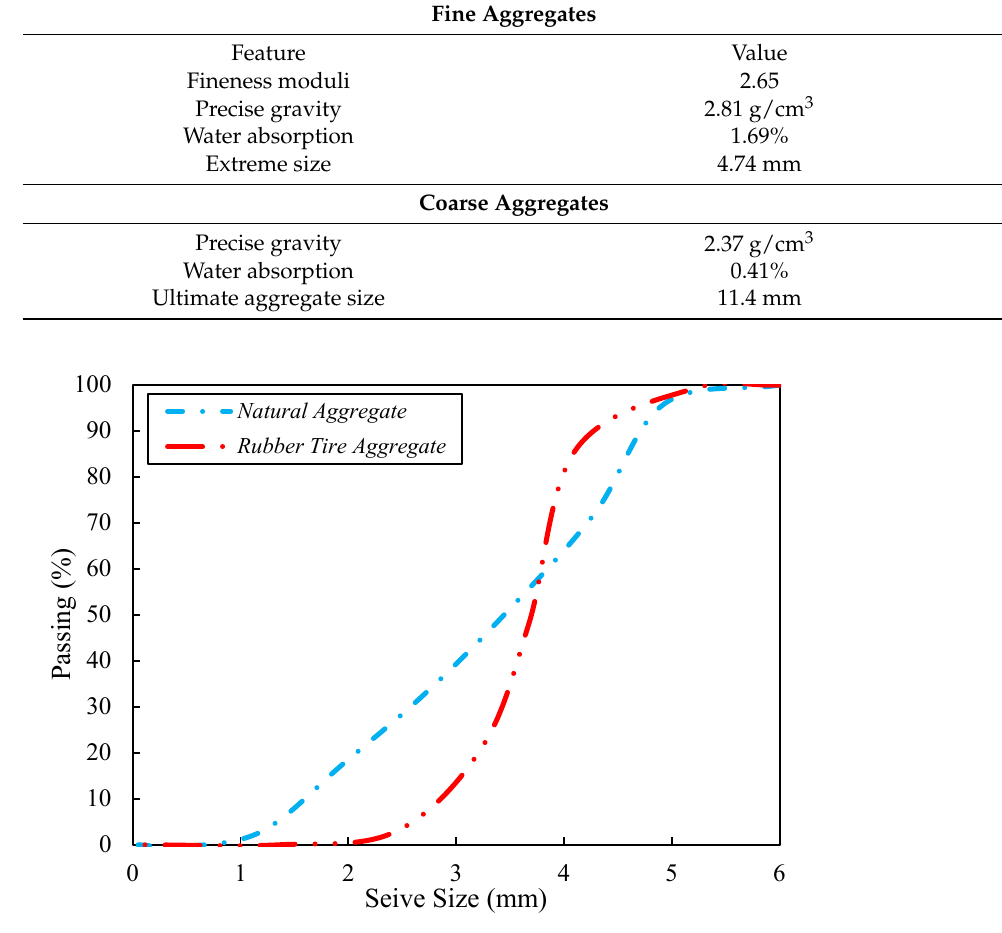
Figure 2. Used aggregates size distribution. Table 3. Concrete mixes design (kg/m 3 ).